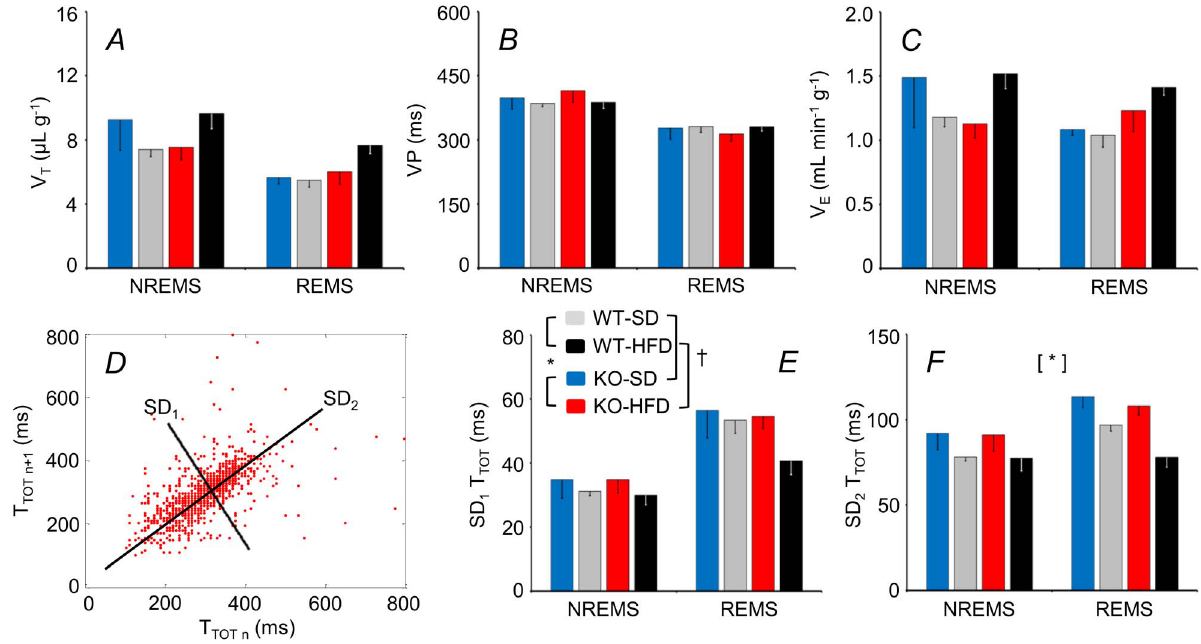
Figure 6. Sleep-related changes in tidal volume, respiratory period, and minute ventilation. Panels A, B, and C show tidal volume (V T ), breath duration (T TOT ), and minute volumes (V E ), respectively, during light period epochs of NREMS and REMS. Panel D shows a Poincare´ plot of T TOT of each breath (n) versus the following breath (n + 1) during REMS for a KO mouse fed a HFD. Panels E and F show the standard deviations of T TOT around a new set of axes oriented with (SD 1 ) or orthogonal to (SD 2 ) the line of identity of the Poincare´ plots, as shown in C; these reflect short-term and long-term variability of T TOT , respectively [20,21]. Data are means 6 SEM for KO mice fed a SD (n=4) or a HFD (n=8) and for WT mice fed a SD (n=7) or a HFD (n=5). For abbreviations and symbols see Figures 1 and 3. Detailed ANOVA results are reported in Table S5.